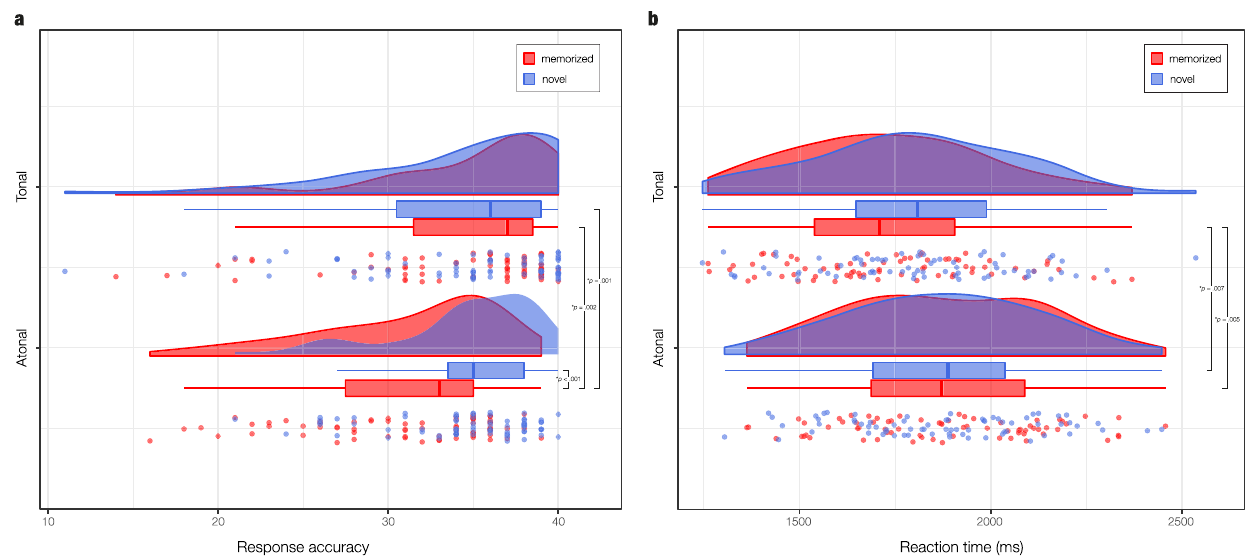
Fig. 2 Analyses of behavioral data. Raincloud plots show the overlapping distributions of memorized and novel sequences in response accuracy ( a ) and reaction time ( b ; in milliseconds). Boxplots show the median and interquartile (IQR, 25 – 75%) range, whiskers depict the 1.5*IQR from the quartile, dots represent the individual data points, and asterisks denote a statistically signi fi cant difference between two conditions ( α = 0.05). The analysis involved n = 71 participants. Table 1 Signi fi cant clusters of activity for the tonal MEG sensor data.